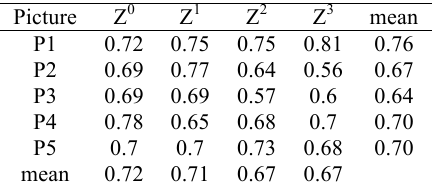
Table 3. Classification accuracies for SVM-linear method, 10- best features selected using t-statistic.